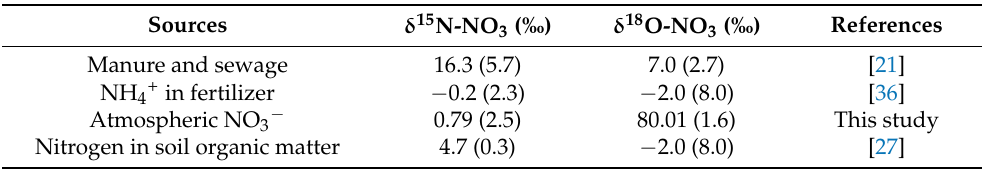
Table 3. Values of δ 15 N-NO 3 and δ 18 O-NO 3 in different sources of nitrogen. Values in brackets represent the standard